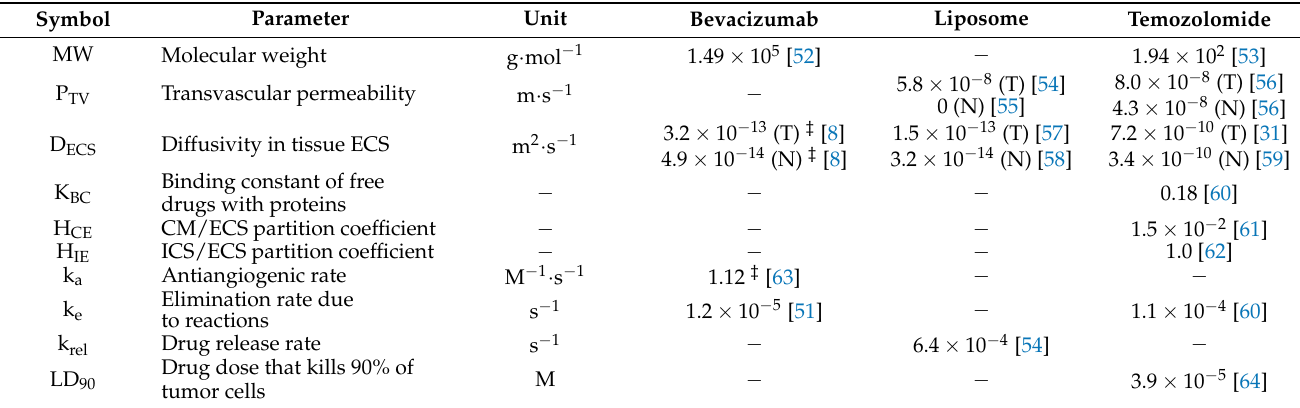
Table 4. Transport and pharmacological properties of drugs